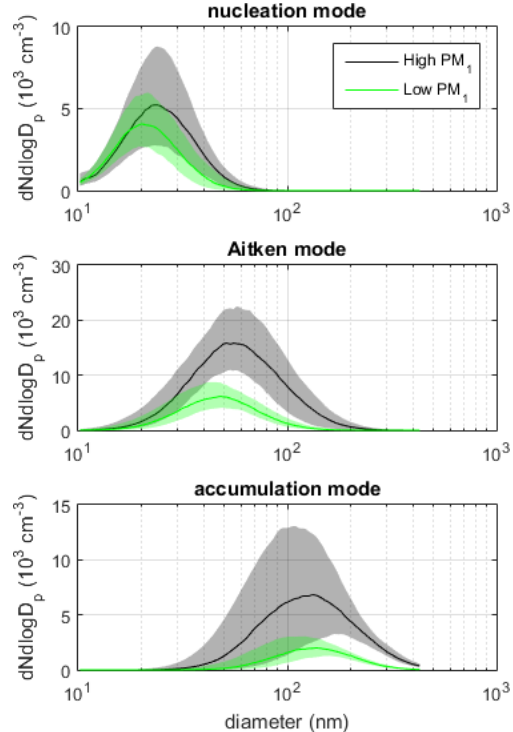
Figure 6. PNSD for nucleation, Aitken, and accumulation modes under high (black) and low (green) PM 1 levels. Solid line repre- sents median PNSD. Shaded areas represent the interquartile inter- val. PM 1 values higher than 75th percentile of time series are con- sidered high-PM 1 concentrations and PM 1 values lower than 25th percentile of time series are considered low-PM 1